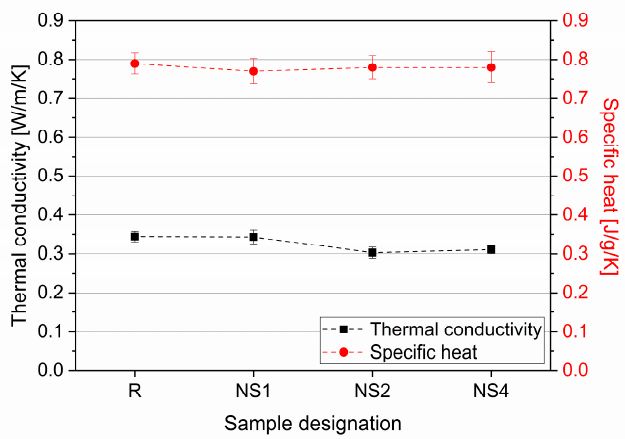
Figure 6. Thermal conductivity and specific heat of tested specimens.